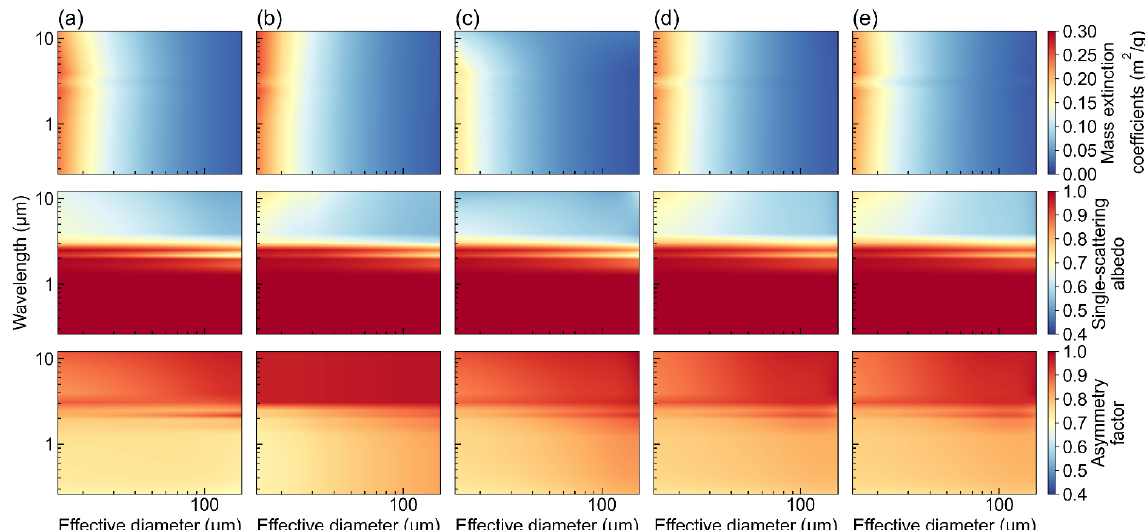
Figure 4. The comparison of (top row) mass extinction coefficients, (middle row) single-scattering albedo and (bottom row) asymmetry factor as functions of effective diameter and wavelength for the (a) Voronoi, (b) Mitchell, (c) Fu, (d) Baum-yang05 and (e) Yi